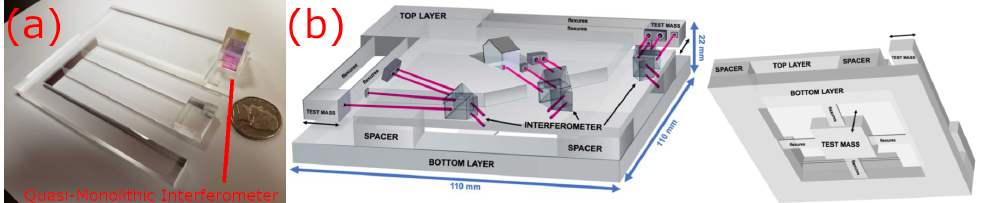
Figure 15. ( a ) A visualization of our quasi-monolithic interferometer integrated onto the wafer of our resonator. A US nickel is included for scale. ( b ) A rendering of a triaxial accelerometer concept. This design consists of two layers: the top containing resonators oscillating in the x and y -axes and the bottom with a resonator operating along the z -axis.